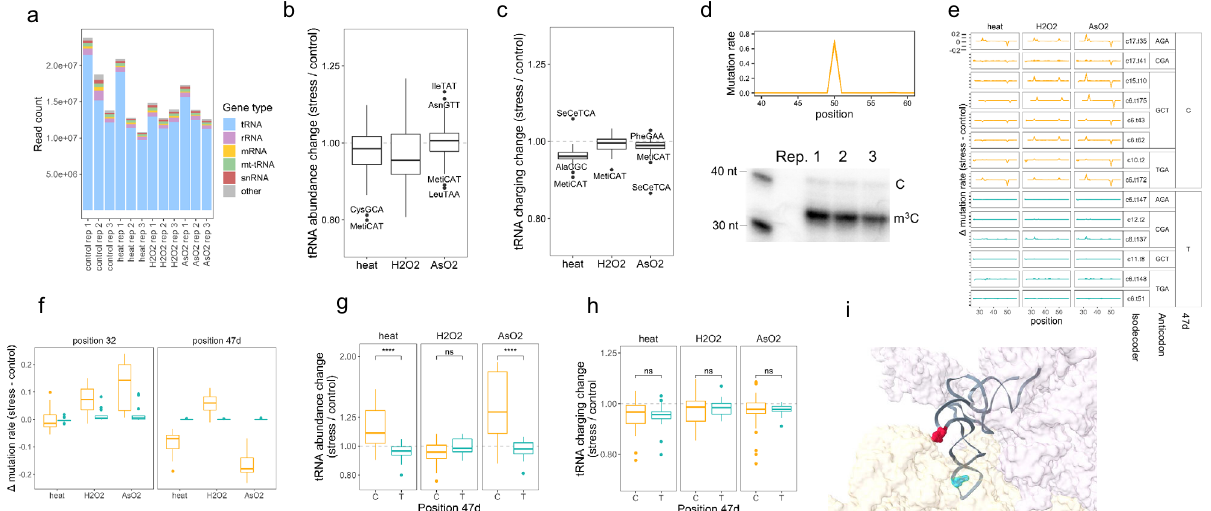
Fig. 3 tRNA analysis in total RNA under stress. MSR-seq was performed in biological triplicates ( n = 3) for each condition using HEK293T cells: unstressed, 42 °C/1 h (heat), 0.6 mM H 2 O 2 /2 h (H 2 O 2 ), 0.3 mM NaAsO 2 /2 h (AsO 2 ). Box and Whisker plots show median, 25th and 75th quartile, and whiskers to 1.5 times interquartile range. a Read coverage among RNA families for each sample. b Stress-induced tRNA abundance change among isoacceptor families. Abundance is calculated as summed normalized coverage of isodecoders in an isoacceptor family. The abundance change upon stress is calculated for each isoacceptor family, averaged across n = 3 independent biological replicates, displaying 46 isoacceptor families. c Stress-induced tRNA charging change among isoacceptor families. Charging is calculated as the ratio of the sum of charged isodecoder reads (CCA-ending) to the sum of uncharged isodecoder reads (CC-ending) for an isoacceptor family. The change in this ratio between stressed and unstressed samples is calculated for each isoacceptor family, then averaged across n = 3 independent biological replicates, displaying 46 isoacceptor families. d Top graph shows the mutation fraction at the 50th nucleotide position in tRNA Ser (GCT) as a representative isodecoder; this position corresponds to 47d in tRNA nomenclature. The three independent biological replicates are shown. The bottom gel image shows validation of sequencing mutation fractions of m 3 C47d in tRNA Ser (GCT) by primer extension: the shorter product indicates an m 3 C-induced RT stop, while the longer product indicates read through of hypomodi fi ed molecules. Source data are provided as a Source Data fi le. e The difference in mutation fraction between stressed and unstressed samples is plotted for tRNA Ser isodecoders, highlighting differences in m 3 C32 and m 3 C47d mutation signature ( n = 3 replicates shown). C47d-tRNA Ser isodecoders are in orange, T47d- tRNA Ser in blue. Isodecoder designations are according to the hg19 genomic tRNA database 59 , e.g., c17.t35 corresponds to chromosome 17, tRNA35. Change in mutation fraction for each replicate is calculated as mutation fraction minus the mean of control replicates. f Summary of data from panel e : mutation fraction at sites corresponding to tRNA Ser m 3 C32 and m 3 C47d change under stress. C47d-tRNA Ser isodecoders are in orange and T47d- tRNA Ser in blue (each point is a tRNA Ser isodecoder). The mutation fraction at T47d is zero; these sites are not methylated. Data were shown for n = 3 independent biological replicates of 8 and 6 C or T tRNA Ser isodecoders, respectively. g Abundance change for C47d-tRNA Ser isodecoders in orange and T47d-tRNA Ser in blue. **** p < 10 − 4 , ns not signi fi cant; signi fi cance calculated with two-sided Wilcoxon test. Data were shown for n = 3 independent biological replicates of 8 and 6 C or T tRNA Ser isodecoders, respectively. P values are 1.2 × 10 − 5 and 1.3 × 10 − 5 for heat and arsenite stress. h Charging change for C47d-tRNA Ser isodecoders in orange and T47d-tRNA Ser in blue. ns not signi fi cant; signi fi cance calculated with two-sided Wilcoxon test. Data were shown for n = 3 independent biological replicates of 8 and 6 C or T tRNA Ser isodecoders, respectively. i Location of m 3 C32 in cyan and m 3 C47d in red in the 3D structure of ribosome-bound tRNA Ser (PDB 6Z6M from ref. 25 ). The 40 S subunit is in light yellow, 60 S subunit is in light (Fig. 3d). In human tRNAs, m 3 C is present in the anticodon loop of tRNA Arg (yCU)/tRNA Ser /tRNA Thr (m 3 C32 in tRNA nomen- clature) and in the loop of the variable arm stem-loop of tRNA Leu (CAG)/tRNA Ser m 3 Ce2